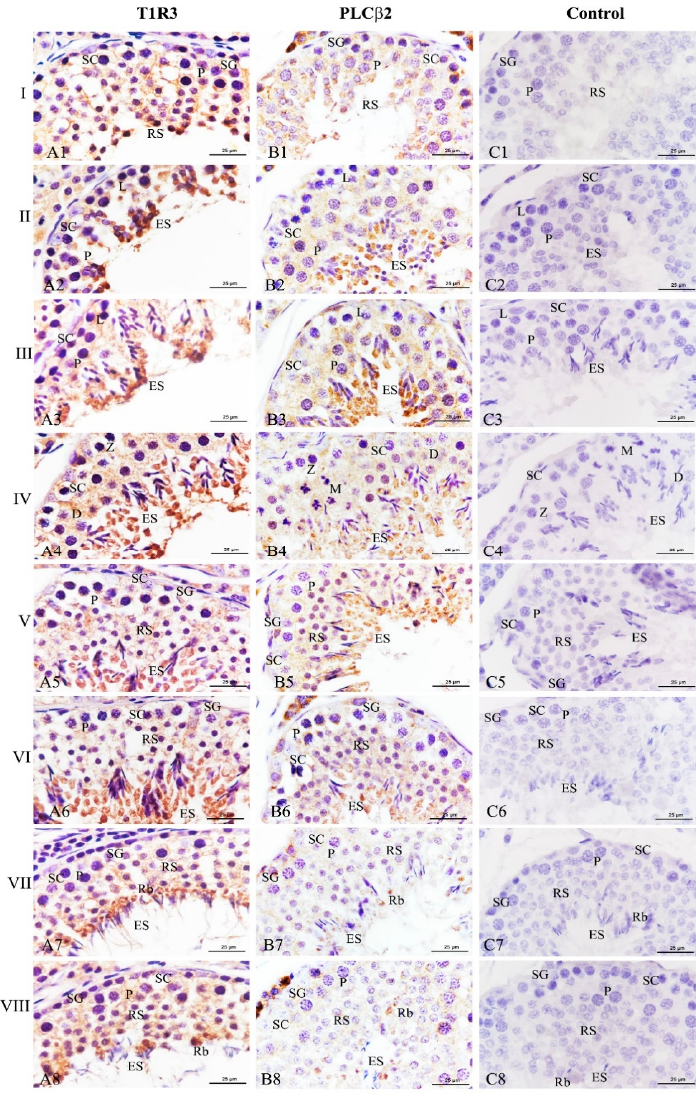
Figure 7. Expression of T1R3 and PLC β 2 during the spermatogenic cycle at 120 days in the testes of the Congjiang Xiang pig. Positive immunostaining in brown, and counterstaining with hematoxylin ( n = 3). ( A1 – A8 ) represent immunostaining of T1R3 antibodies at stages I–VIII. ( B1 – B8 ) represent immunostaining of PLC β 2 antibodies at stages I–VIII. ( C1 – C8 ) represent negative control at stages I–VIII, which was performed with PBS instead of primary antibody. Leydig cells (LC); Sertoli cells (SC); spermatogonia (SG); leptotene and zygotene spermatocytes (L/Z); preleptotene spermatocytes (PL); pachytene spermatocytes (P); round spermatids (RS); elongating/elongated spermatids (ES); residual bodies (Rb). Scale bars: A1–A8 = 25 µ m (1000 × magnification); B1–B8 = 25 µ m (1000 × magnification); C1–C8 = 25 µ m (1000 ×